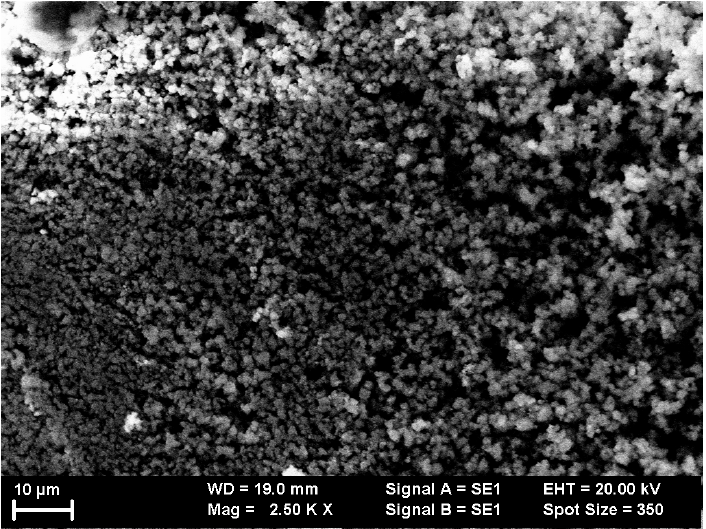
Figure 1. The surface of Cr 47 Al 27 C 26 as-deposited thin film, as revealed by the scanning electron microscopy images.